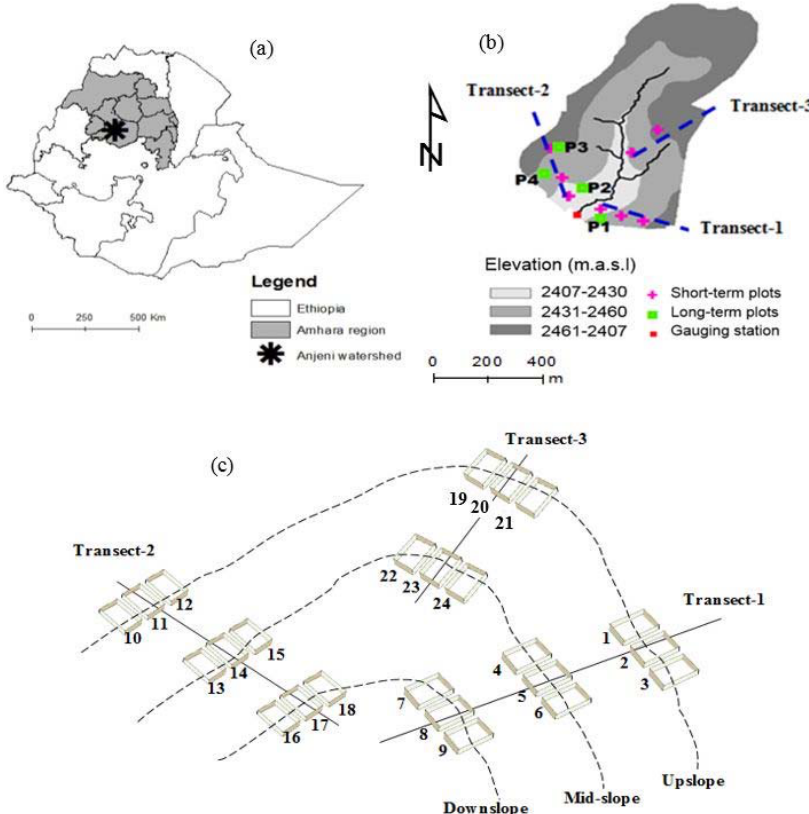
Figure 1. Map of the Anjeni watershed in the Northern Ethiopian Highlands ( a ), with the location of downslope transects and runoff plots indicated in ( b ) and ( c ) (not to scale) (source: [28]). Dashed lines in ( c ) are elevation contours. Three treatments were applied: barley without soil amendment (control) was grown on plots 2, 4, 7, 12, 15, 18, 21, 23; barley with charcoal amendment was grown on plots 1, 6, 8, 11, 13, 17, 20, 22; lupine without soil amendment was grown on plots 3, 5, 9, 10, 14, 16, 19, 24. Soil and spatial attributes of plots are presented in Table 1. Table 1. Soil properties of plots with static gas sampling chambers (source: [28]).